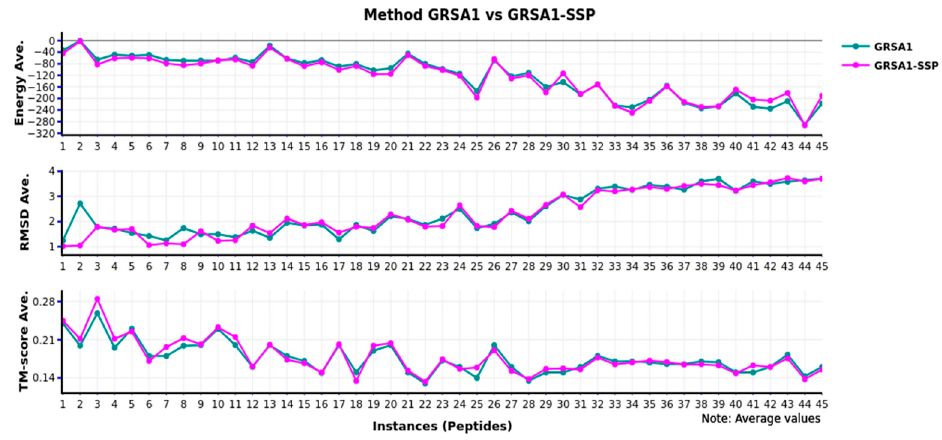
Figure 3. Comparison of GRSA1 versus GRSA1-SSP.